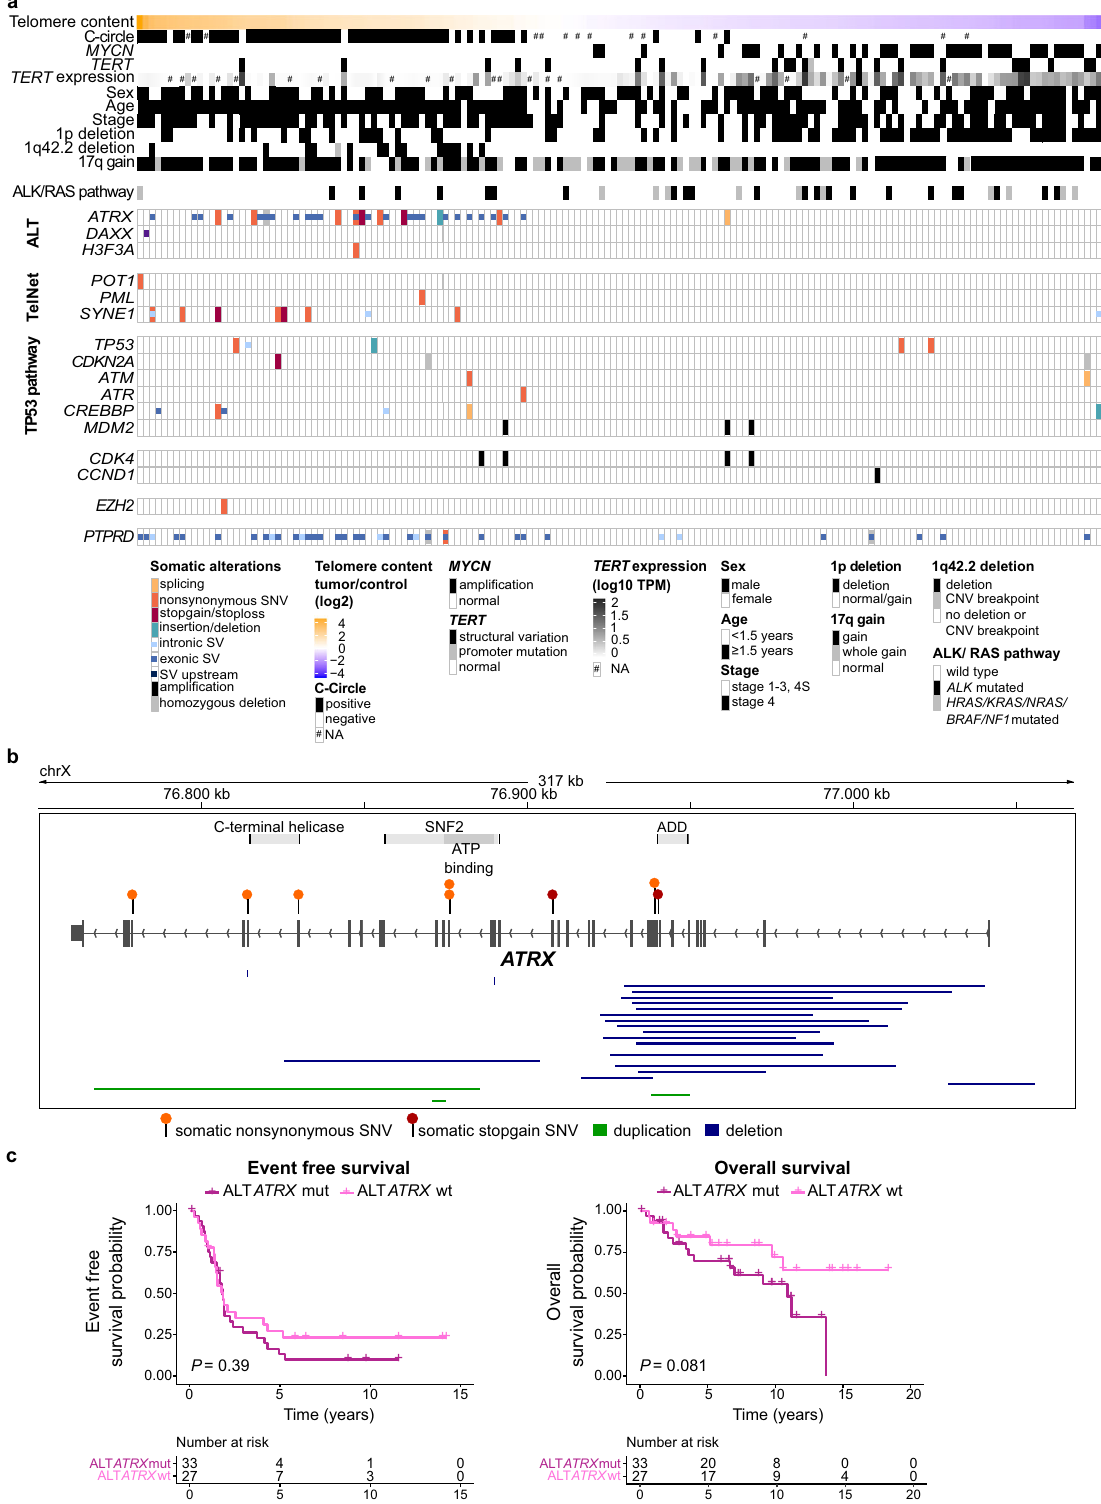
canonical telomeric repeat sequence, which is more than one would expect by chance. This enhanced microhomology at the junction sites of telomeric repeat loci indicates that telomeric sequences were added via a microhomology-dependent mechanism (Supplementary Fig. 15d-f). In general, 55.3% of all telomeric repeat loci were associated with a chromosomal